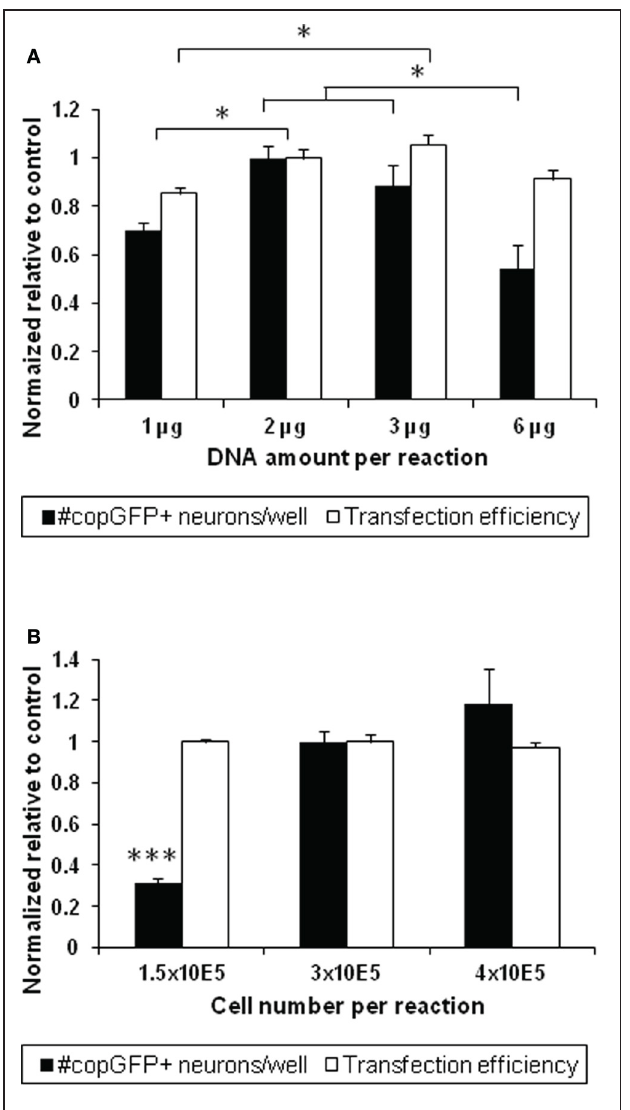
FIGURE 3 | Optimization of DNA amount and cell number for transfecting adult dorsal root ganglion neurons. (A) Altering the amount of DNA and the percent volume of plasmid in the reaction mixture influences the number of transfected neurons at 48h ( n = 3–9 wells across three experiments; ANOVA p < 0 . 01; black bars). A low amount of DNA (1 μ g) resulted in a significantly lower number of copGFP-positive neurons compared to 2 μ g DNA comprising the same percent reaction volume (10% of the 20 μ l vessel; p < 0 . 01). Increasing the DNA amount (6 μ g comprising 30% of the reaction volume) also resulted in 39%–46% fewer transfected cells compared to reactions with 2 and 3 μ g DNA, respectively ( p < 0 . 05). Using 1 μ g DNA also lowered transfection efficiencies from values achieved with 2 and 3 μ g DNA ( p < 0 . 05; white bars). The condition with 2 μ g DNA was set as 100% to normalize across different experiments. (B) Three cell concentrations were tested to determine whether cell numbers would influence the transfection output using 2 μ g of DNA. While no significant difference was seen in transfection efficiency at 48 h, lowering the cell number to 1 . 5 × 10 5 cells significantly diminished the absolute number of transfected neurons per well disproportionally by more than three-fold (ANOVA p < 0 . 001). All values are relative to the 2 μ g DNA and 3 × 10 5 cells condition within the same experiment. ∗ p < 0 . 05; ∗∗∗ p < 0 . 001.